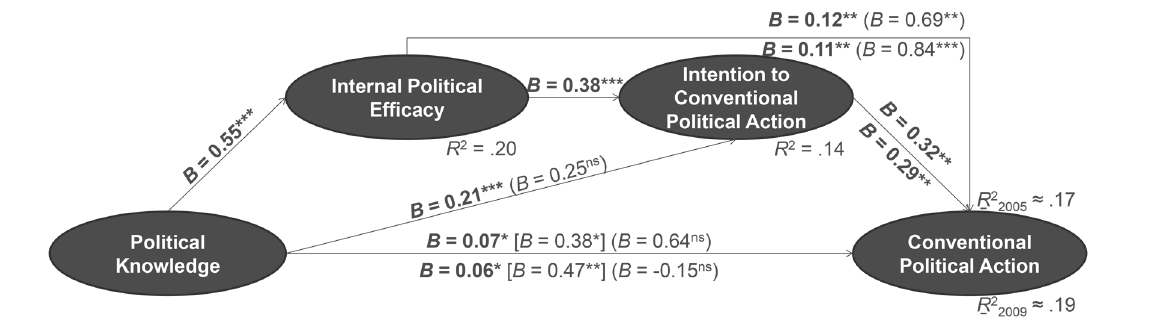
Figure 2. Prediction of conventional political participation by political knowledge, sequentially mediated through internal political efficacy and intention to participate in conventional political action (effects on conventional participation between 2002 and 2005 above lines; effects on conventional participation between 2005 and 2009 below lines; n = 2,353). Note. Unstandardized regression weights; direct effects in mediated regressions in round parentheses; indirect effect of political knowledge by internal political efficacy on actual behaviour in squared parentheses.